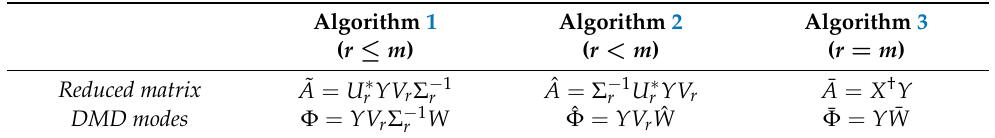
Table 1. Reduced matrices and DMD